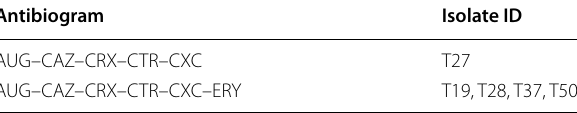
Table 3 Drug resistance among